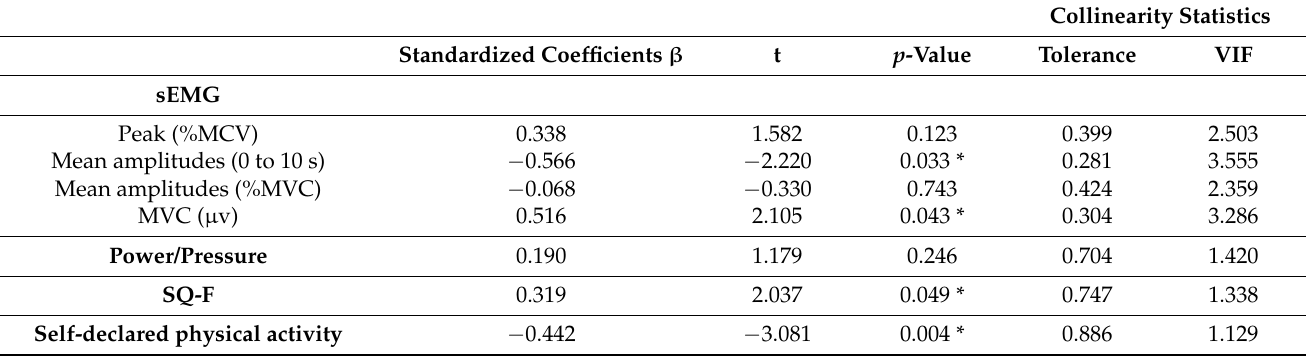
Table 4. Relationship of pelvic floor muscle functionality, Sexual Quotient—Female version (SQ-F), and self-declared physical activity with the handgrip strength in healthy women with interactions.